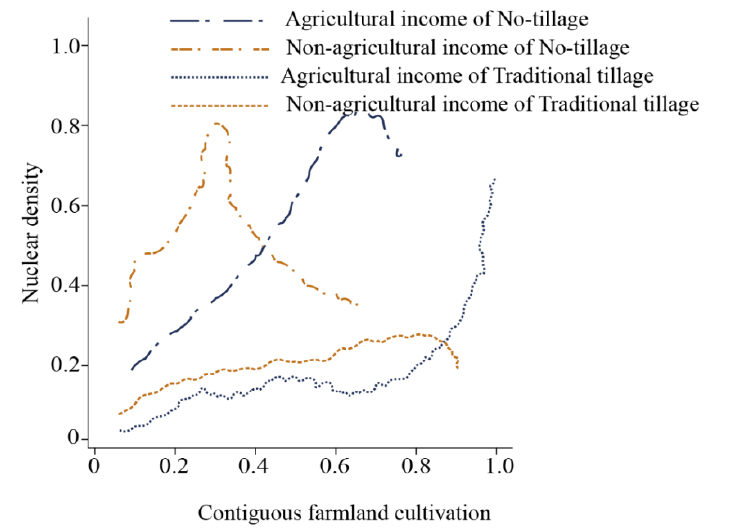
Figure 4. Nuclear density curve between the contiguous farmland cultivation and transferees’ income structure (Source: field survey